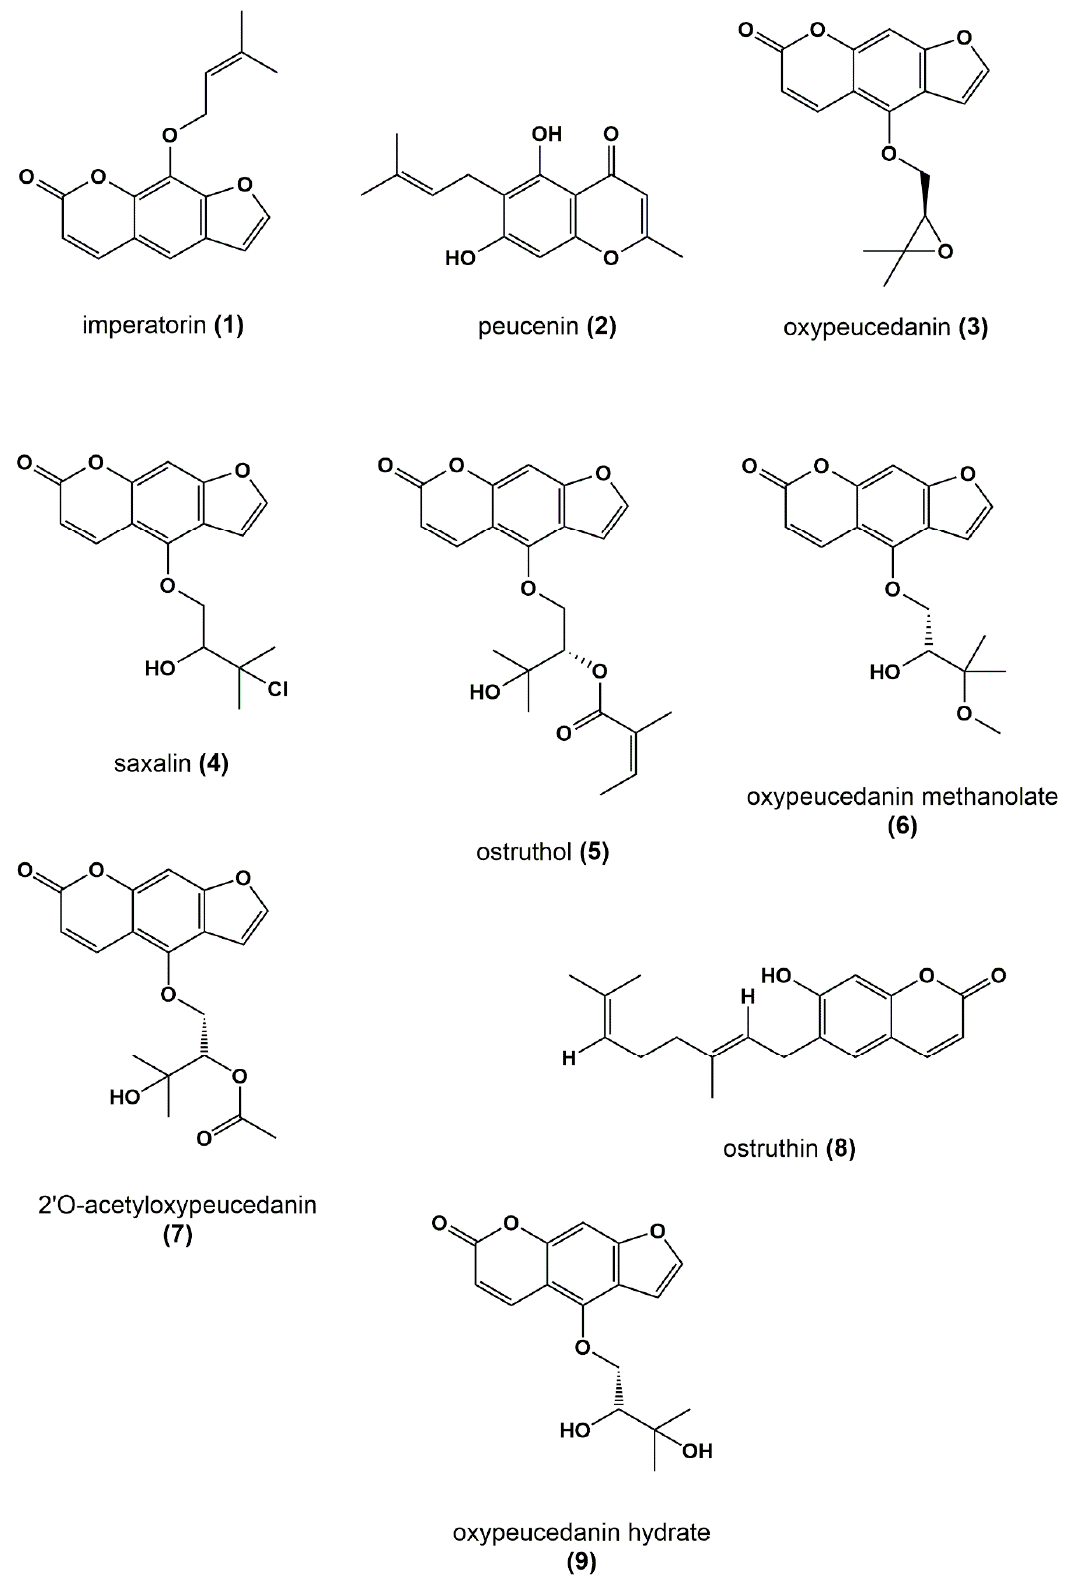
Figure 8. Chemical structures of identified P. ostruthium constituents.